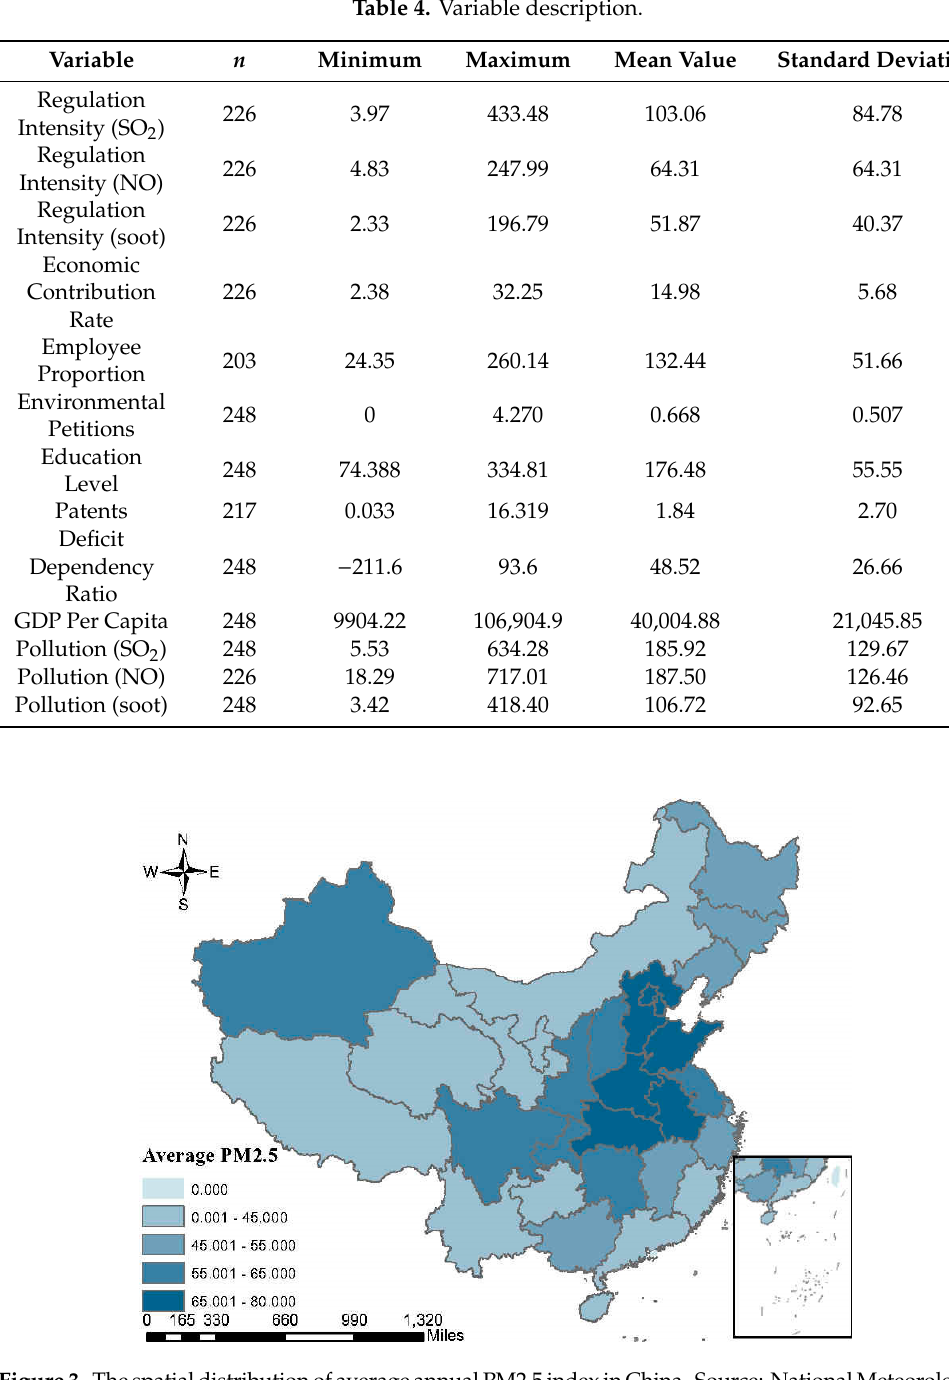
Figure 4. The spatial distribution of average annual economic contribution rate (CRPI) of six polluting industries in China. Source: Calculated by the authors on the basis of the Environmental Statistics Yearbook of China, 2005–2015.